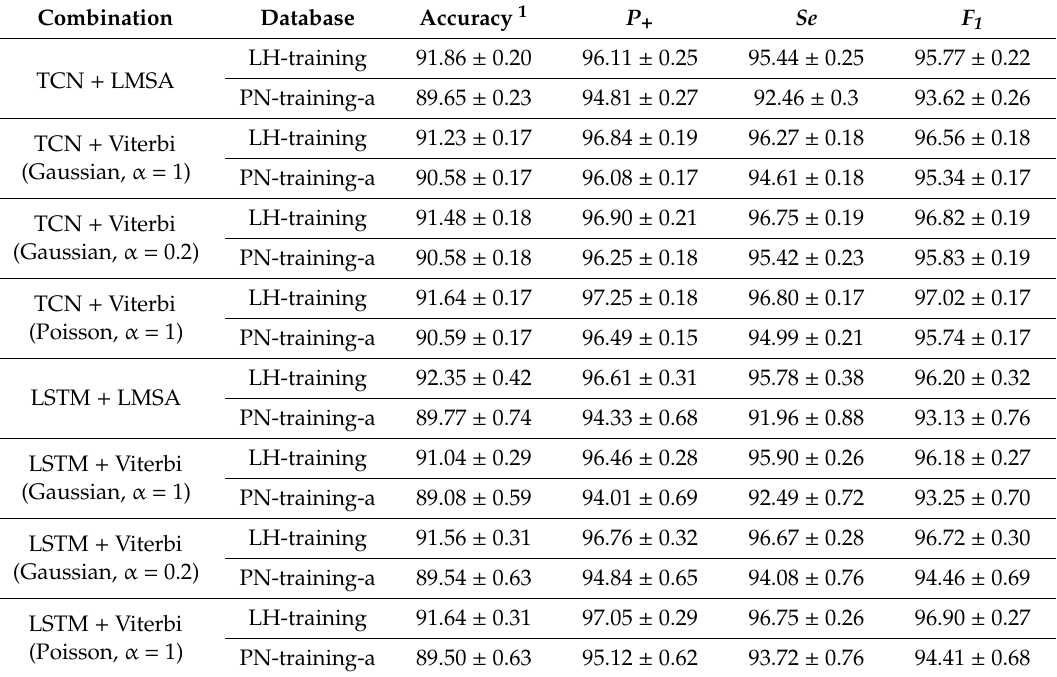
Table 3. Comparison of various combinations of feature classification methods and state annotation methods using the testing sets in two databases (%).